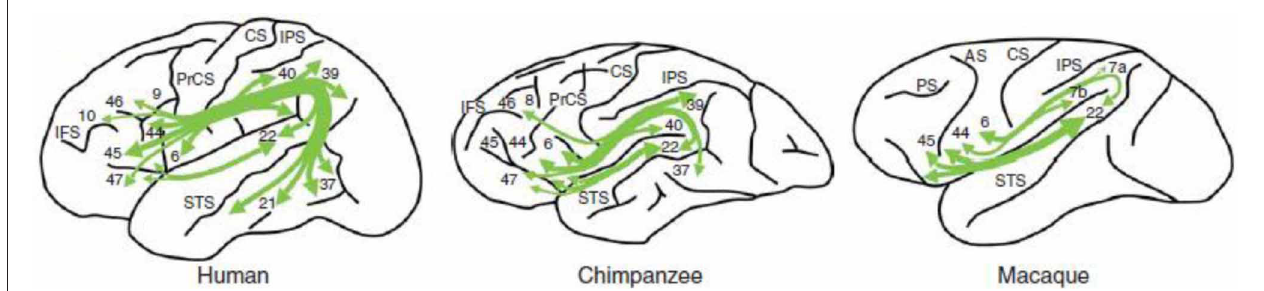
FIGURE 4 | The arcuate fasciculus in human, chimpanzee and macaque in a schematic lateral view of the left hemisphere. From Rilling et al. (2008); courtesy of Nature Publishing Group.